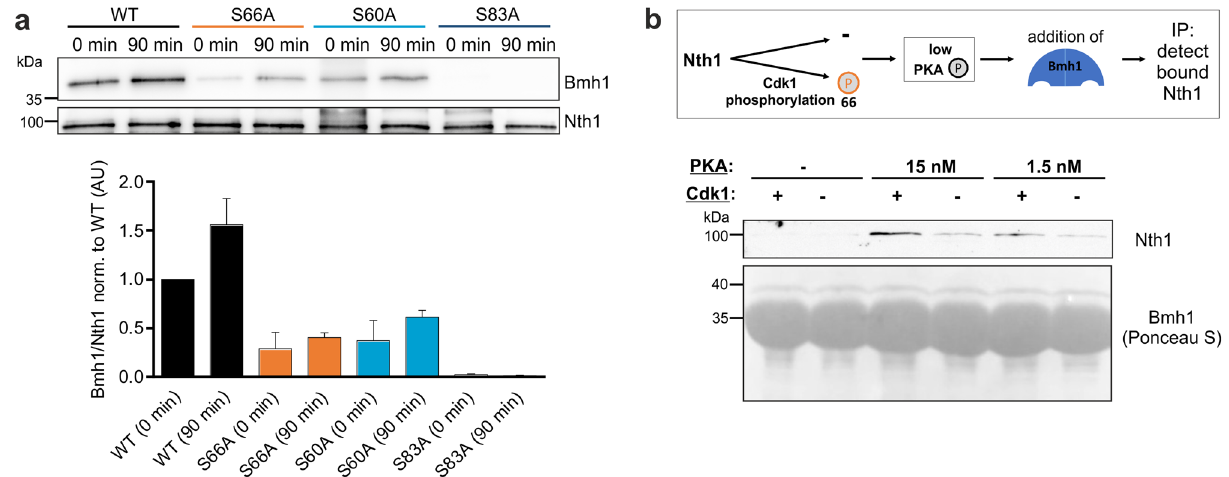
Figure 4. Bmh1 binding during the cell cycle is dependent on CDK and PKA phosphorylation. ( a ) Co-Immunoprecipitation of cells expressing full-length 3x-FLAG tagged Nth1 and V5-tagged Bmh1 grown on 1% EMM and synchronously released from G 1 arrest. Mean ± SD of the quantification of 4 blots from two biological with two technical replicates each. ( b ) Co-Immunoprecipitation of recombinant full-length 6xHis- tagged-Bmh1 and Nth1-Strep-tagged after in vitro phosphorylation of Nth1 with either PKA or PKA and